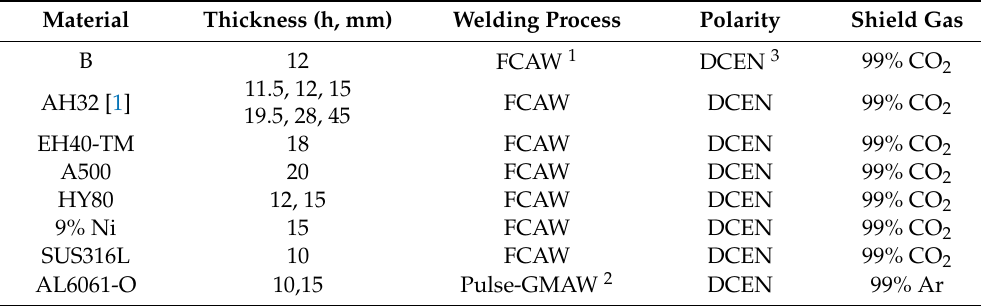
Table 2. Welding conditions for BOP experiments.